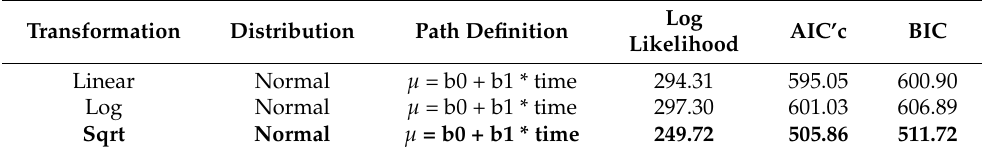
Table 5. Flexural model list.